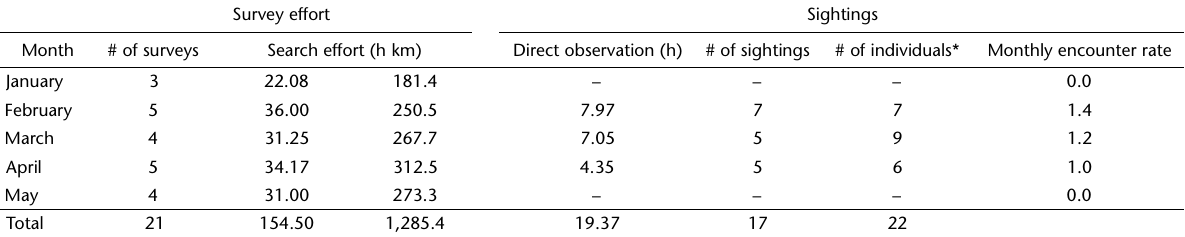
Table 1. Sampling effort and sighting data of Bryde’s whale, Balaenoptera edeni , off Rio de Janeiro coast from January through May 2014. (h) Hours, (km) kilometers. Survey